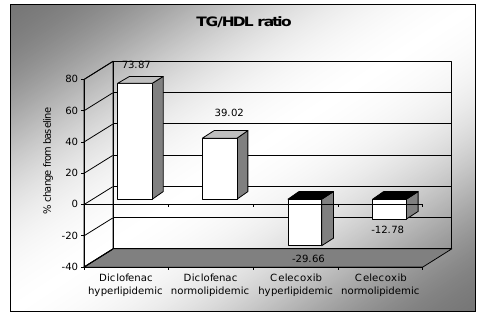
Figure (6): - % change in serum TG/HDL ratio concentration from baseline value after 8weeks treatment with diclofenac or celecoxib in hyperlipidemic and